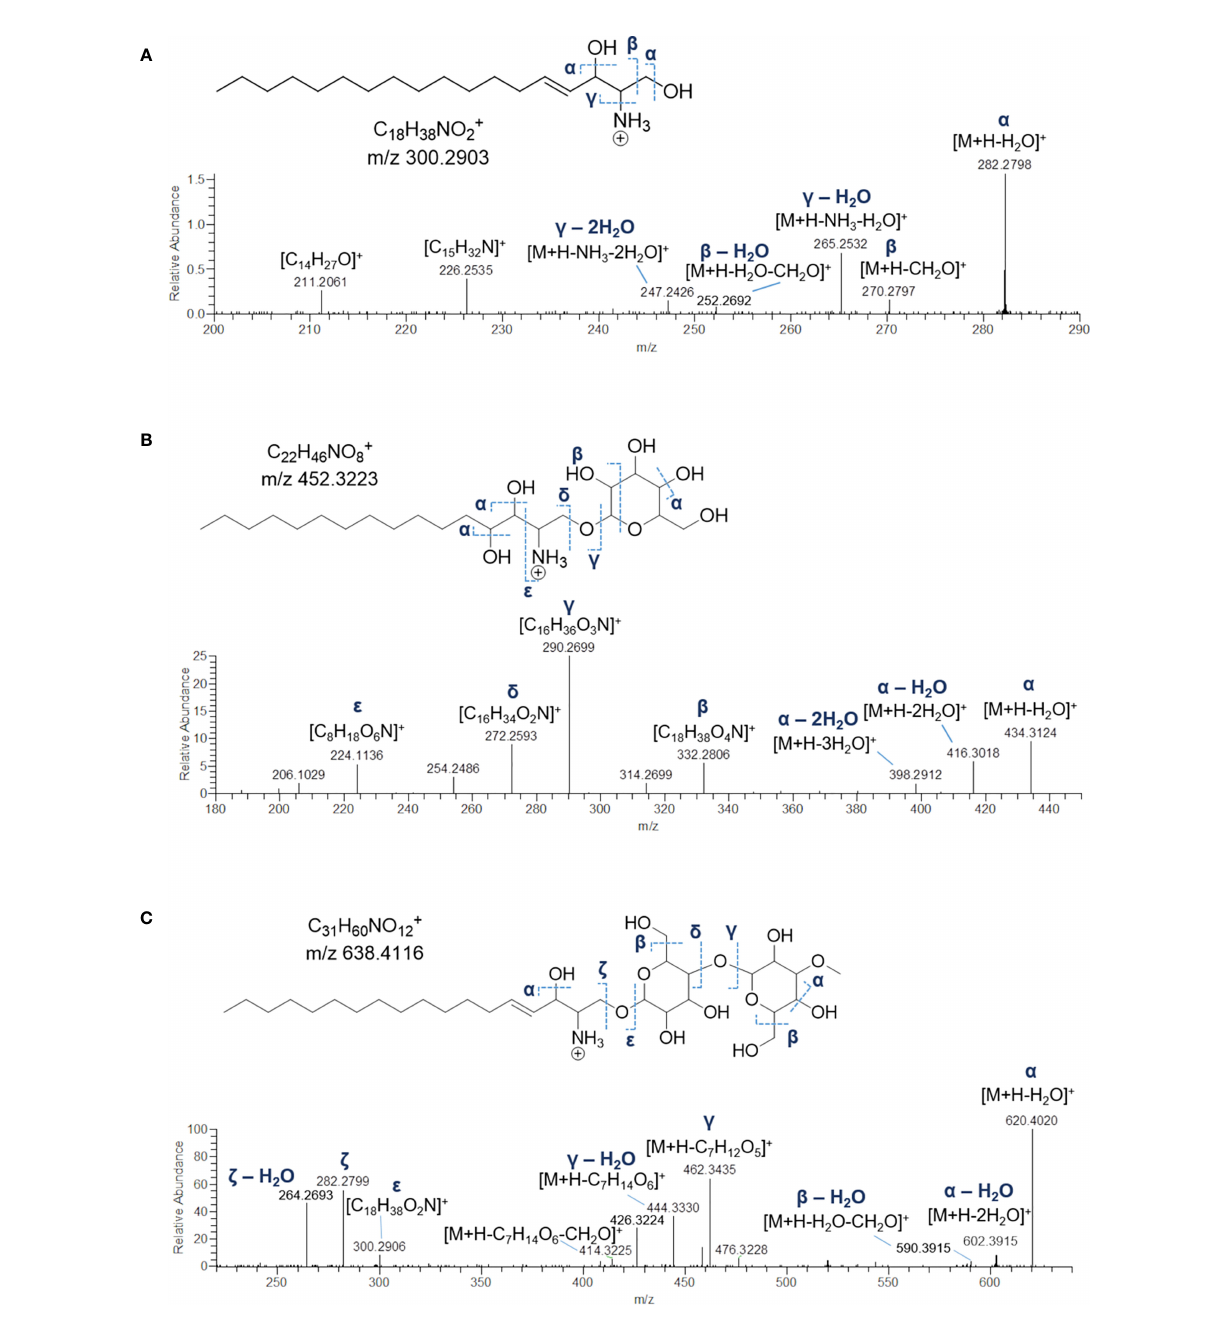
FIGURE 6 | Fragmentation patterns and HR ESI-MS 2 spectra of [M+H] + ions of sphingosine (SPB 18:1;O2) (A) , hexosyl-C16 hydroxysphinganine (B) and dihexosyl- sphyngosine (C) from Botrylloides niger